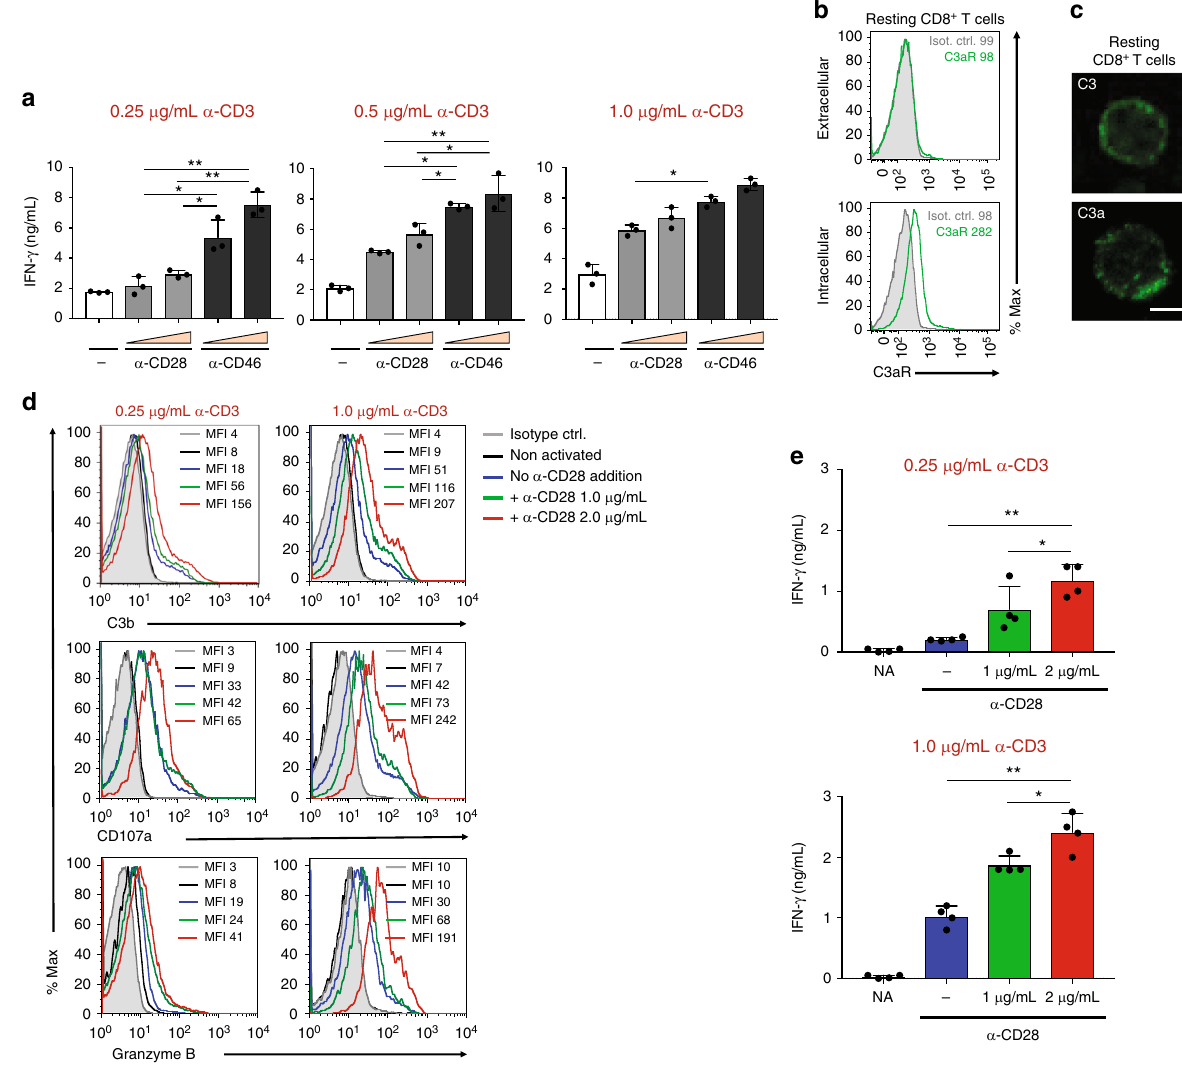
Fig. 2 Autocrine CD46 engagement supports CTL activation. a Comparison of effects of TCR stimulation as well as CD28 and CD46 co-stimulation on IFN- γ secretion by CTLs. Puri fi ed CD8 + T cells were activated with the depicted antibody combinations (for CD28 and CD46 either 1 μ g/mL or 2 μ g/mL at all tested CD3 stimulation conditions) for 60 h and IFN- γ secretion measured ( n = 3). b , c Extracellular and intracellular C3aR, C3, and C3a presence in resting human CD8 + T cells. Freshly puri fi ed CD8 + T cells were either left non-permeabilized or were permeabilized and stained with antibodies to the C3aR, to C3 and C3a and evaluated by FACS ( b ) or confocal microscopy ( c , scale bar = 7 μ m) for presence and localization of the respective antigens (data shown are one representative of n = 3). d , e Effects of increasing TCR and CD28 activation on C3b generation, CD107a and granzyme B expression and cytokine secretion. CD8 + T cells were left non-activated (NA) or activated with the depicted antibody combinations and C3b surface presence, CD107a and granzyme B positivity ( d , shows a representative FACS analysis of two similarly performed experiments; gray histograms, isotype controls; black histograms, non-activated cells; blue histograms, no CD28 stimulation; green and red histograms, addition of 1 or 2 μ g/mL α -CD28, respectively) and IFN- γ production ( e ) measured at 12 h post activation ( n = 3). The gating strategy for CD8 + T cells fl ow cytometry staining is shown in Supplementary Fig. 7b. Error bars denote mean ± SEM. * p < 0.05; ** p < 0.01; ns, statistically not signi fi cant; ctrl. Control. Statistical analyses were performed using